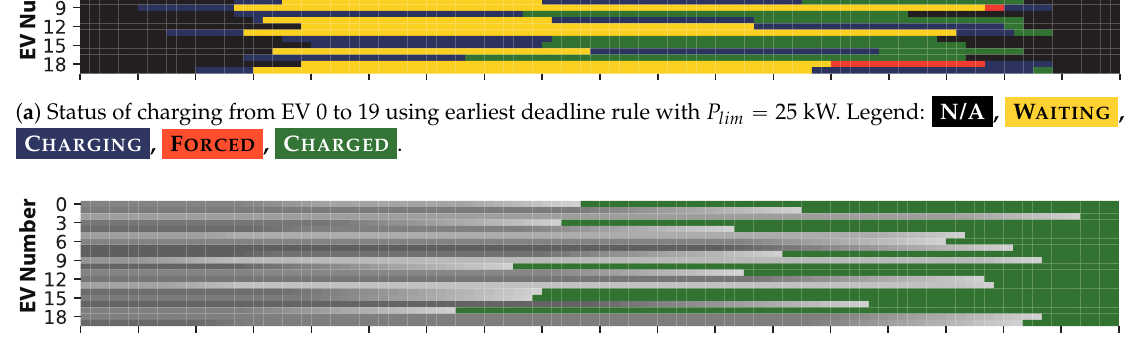
( b ) Battery charge levels from EV 0 to 19 using earliest deadline rule with P lim “ 25 kW. Darker grey tones indicate lower values. Green color means that the battery is charged.